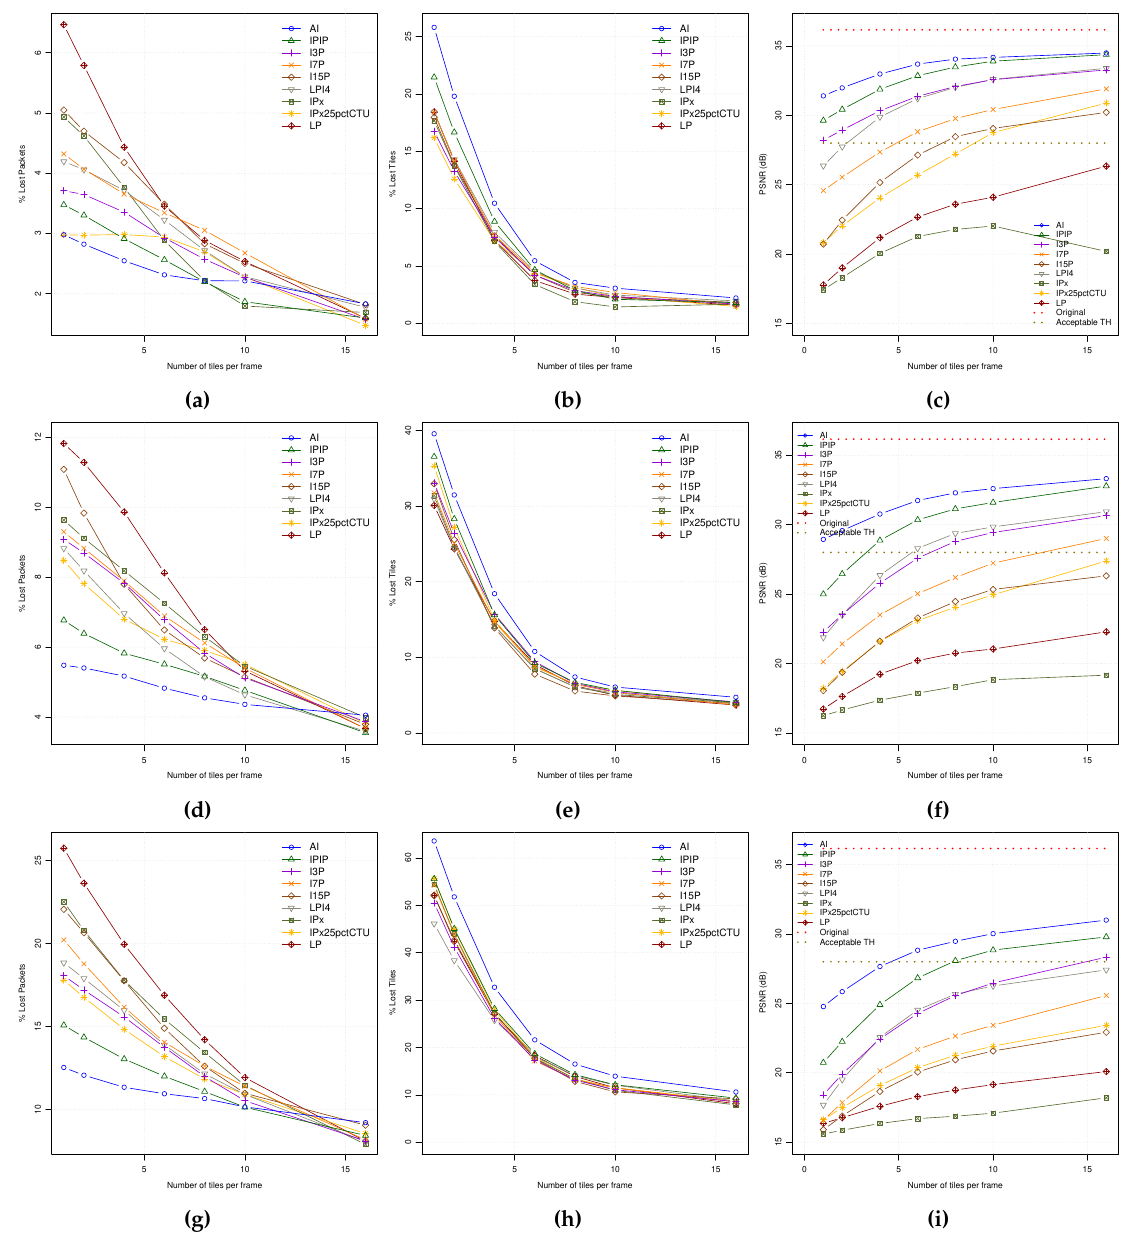
Figure 7. QoE statistics for all the encoding modes for all the tiles per frame layouts at different background traffic levels: ( a,b,c ) PLR, TLR, PSNR (12 pps). ( d,e,f ) PLR, TLR, PSNR (25 pps). ( g,h,i ) PLR, TLR, PSNR (50